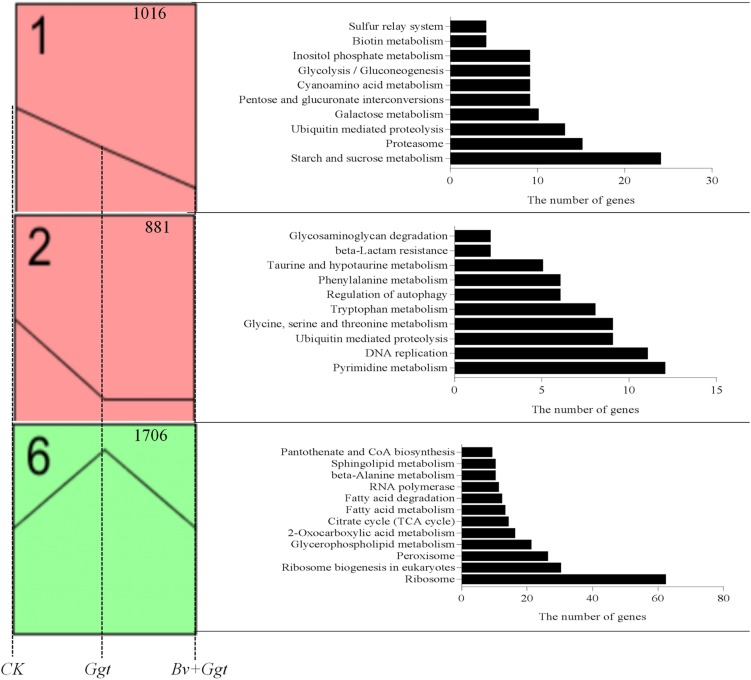
The significant (P values < 0.05) expression profiles generated by the analysis of the RPKM value based on the Ggt transcriptomic data of CK, Ggt, and Bv+Ggt treatments. The figure at the upper right corner represents the gene number. All significant annotated KEGG pathways for each profile are listed on the right shown by histograms. CK, the Ggt sample on the PDA plates; Ggt, the wheat roots infected with pathogen Ggt; Bv+Ggt, the Ggt-infected wheat roots in the presence of Bv.